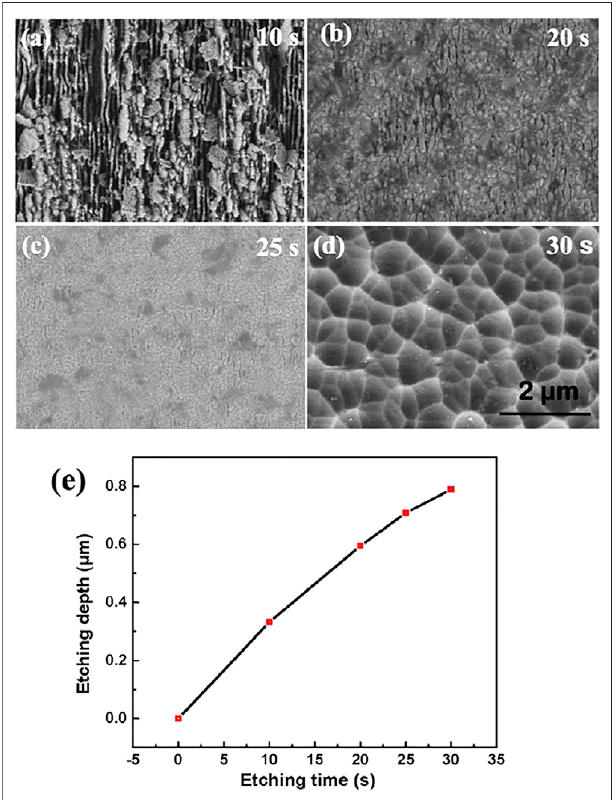
FIGURE 9 | (A – D) SEM images of nanostructured FTO fi lms with different etching times. (E) The depths changing with the etching